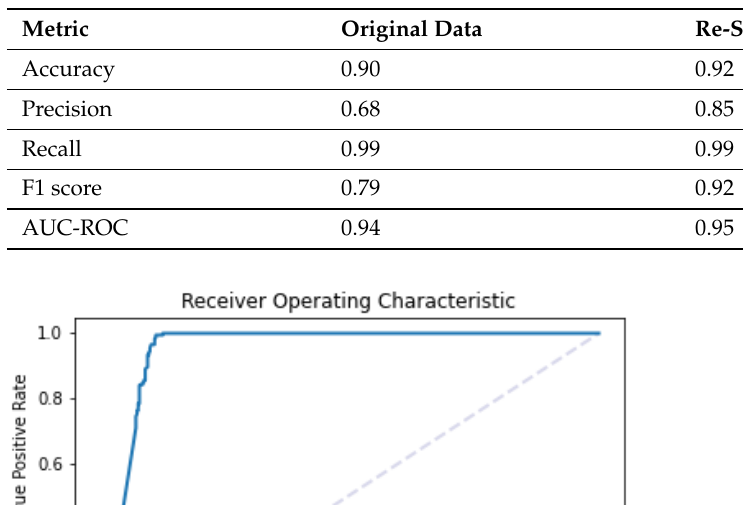
Figure 3. Training and Test Confusion matrices. ( a ) Training confusion matrix; ( b ) Test confusion matrix. Table 2. Model Evaluation.